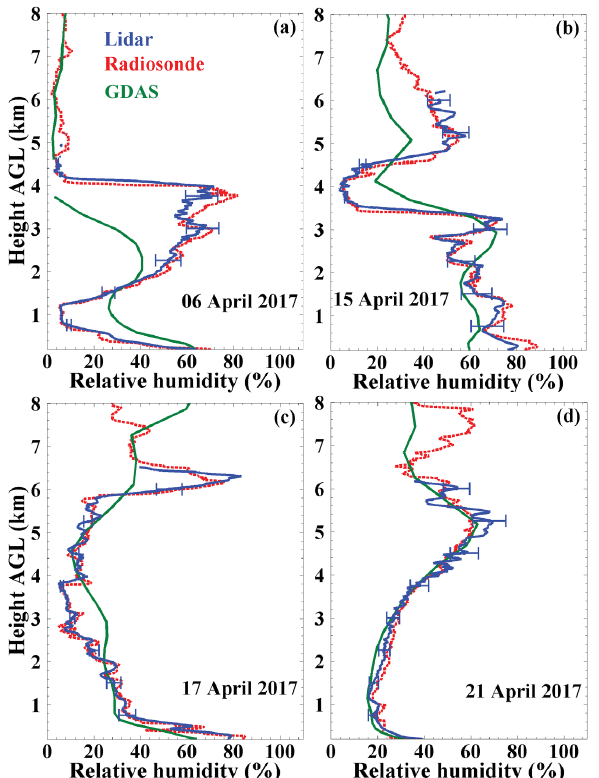
Figure 12. Relative humidity (RH) computed from 30min mean water vapor mixing ratio profiles measured with lidar and by fur- ther use of meteorological data from GDAS (blue solid lines). The lidar profiles are compared with radiosonde RH profiles (red dotted profiles) and modeled RH profiles (green curves). The radiosondes were launched during the lidar observations at the lidar field site about 1–2h after